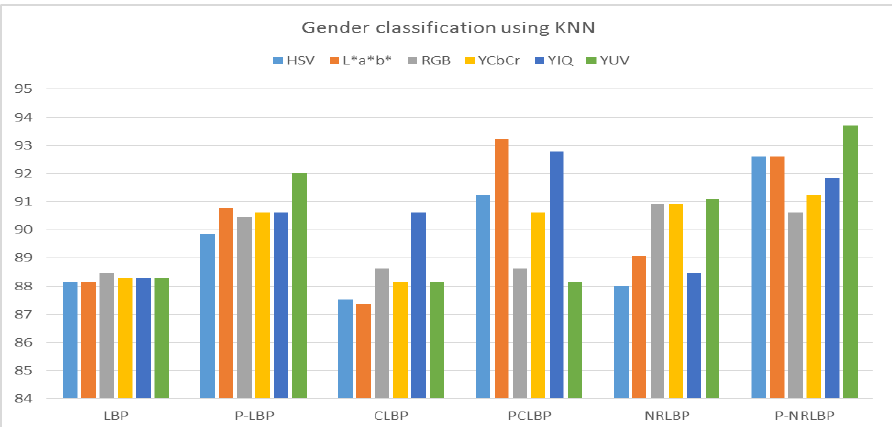
Figure 5. Gender classification using KNN (FERET database).